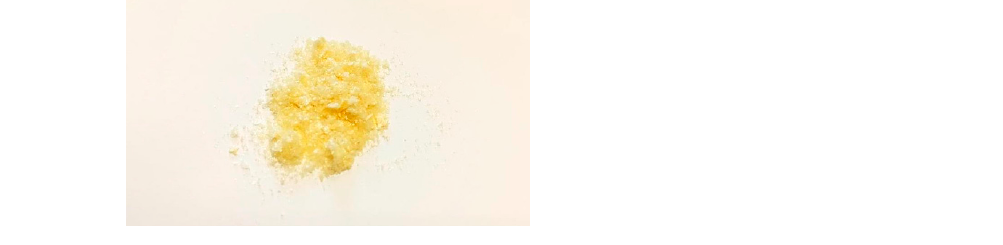
Figure 2. Dried phenolic extract from the seeds of the Moraiolo cultivar at the fourth sampling point.